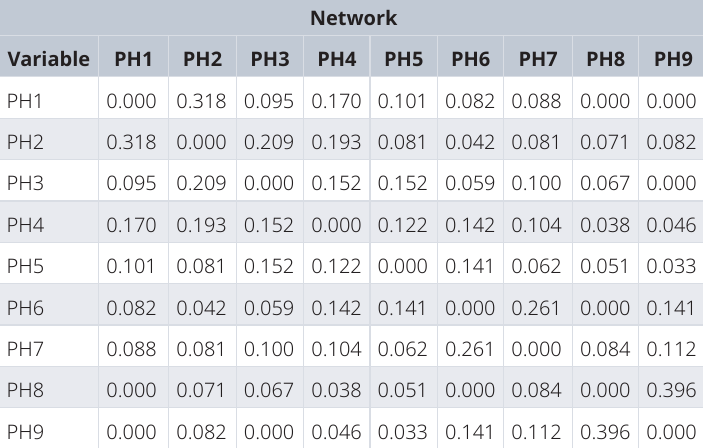
Table 2. Weight matrix of PHQ-9 items.